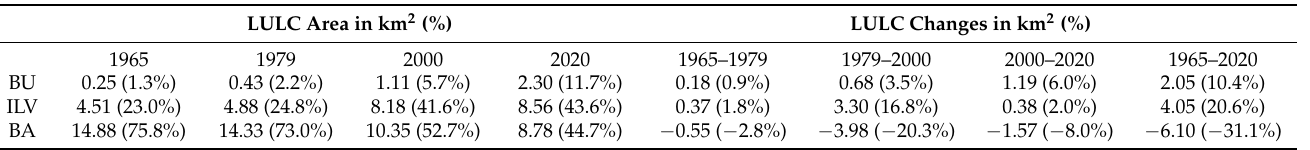
Table 4. Percentage and square kilometre of land use and land cover (LULC) in 1965, 1979, 2000 and 2020 and their changes.